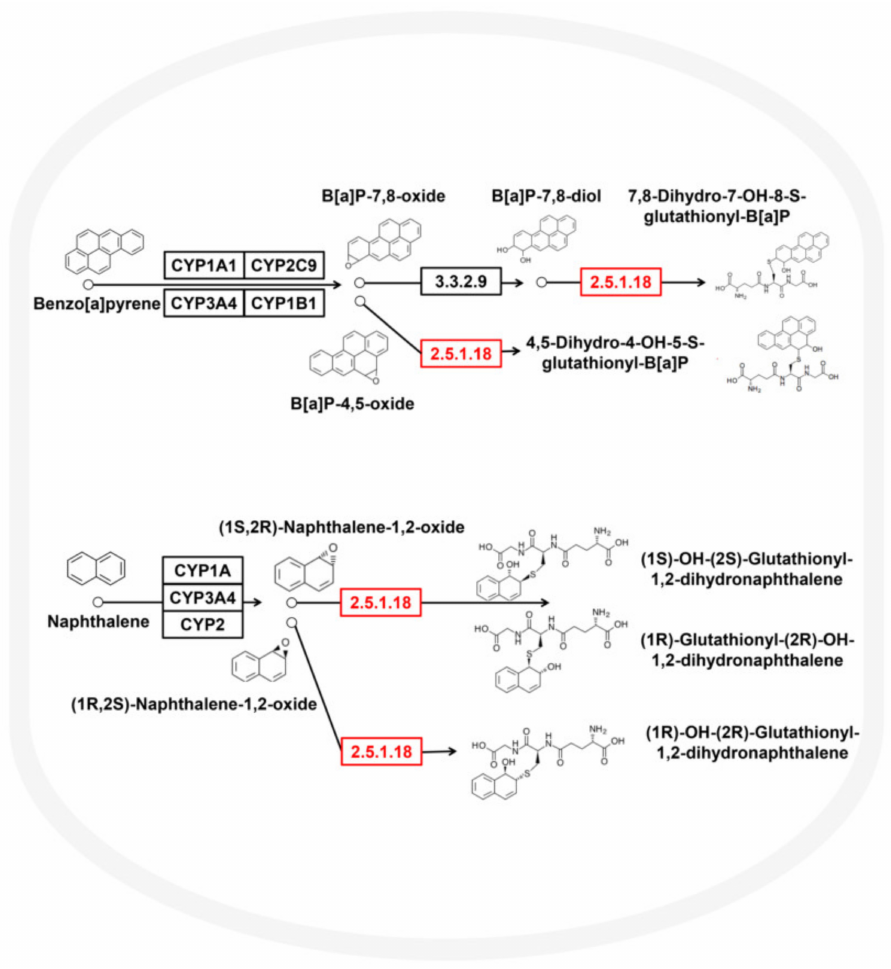
Figure 3. Sphingomonas sp. metabolic pathways for the degradation of